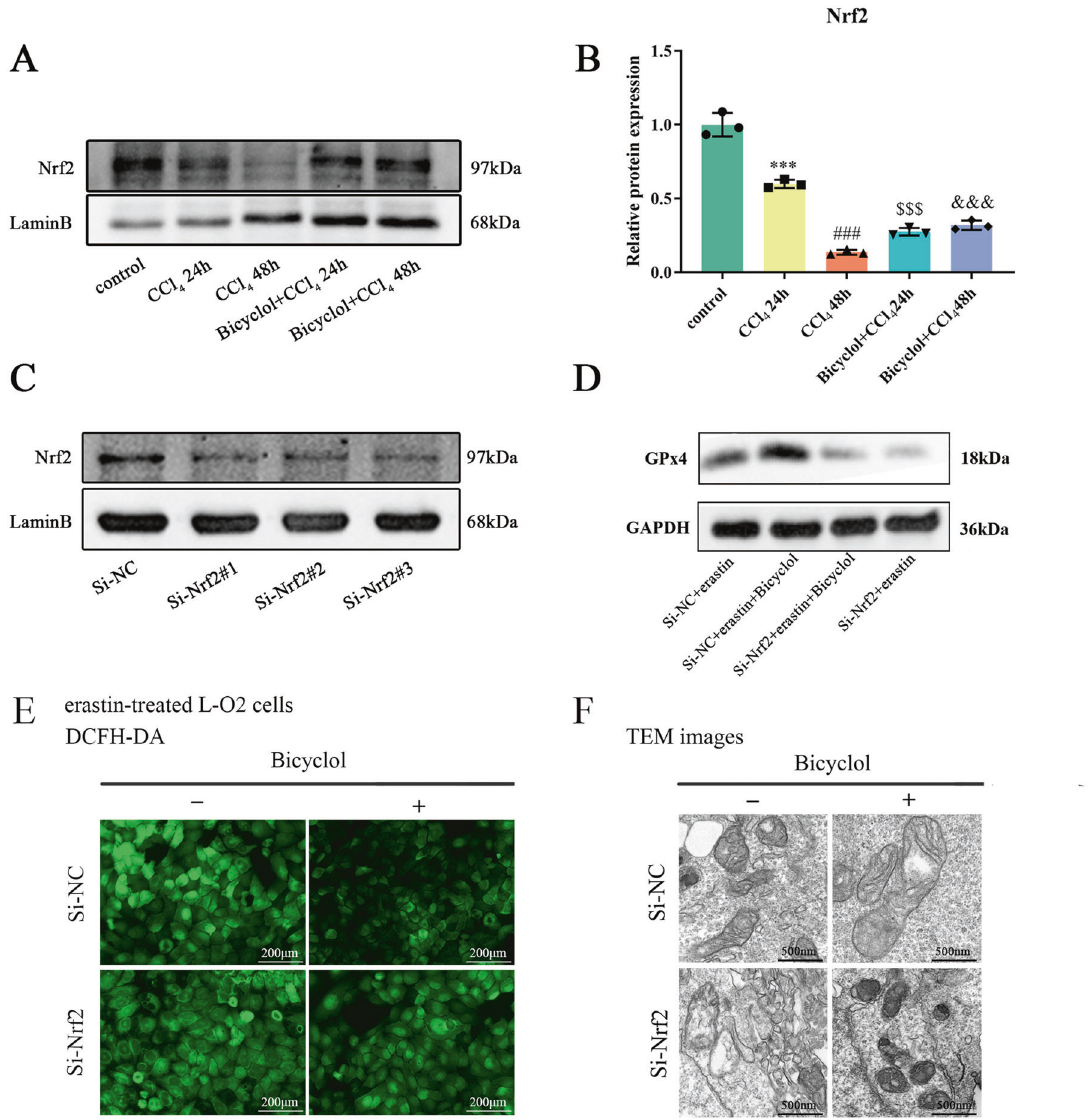
Fig. 8 Bicyclol attenuates hepatocellular ferroptosis by regulating Nrf2-GPx4 axis. A Nuclear protein levels of Nrf2 in liver tissues at 24 and 48 h after CCl 4 exposure. B The band intensities of Nrf2 relative to LaminB were quanti fi ed by image J software. C Protein levels of Nrf2 in L-O2 cells transfected with nontargeting control siRNA or Nrf2 siRNA. D Protein levels of GPx4 in erastin-treated L-O2 cells transfected with nontargeting control siRNA or GPx4 siRNA. E Cellular ROS content in L-O2 cells transfected with nontargeting control siRNA (NC siRNA) or Nrf2 siRNA was assessed by DCFH-DA probe. F TEM was used to detect the mitochondrial morphology of L-O2 cells transfected with NC siRNA or Nrf2 siRNA upon different treatment. Data were expressed as mean ±SD. *** p <0.001 vs control group, ### p <0.001 vs control group, $$$ p <0.001 vs CCl 4 24h group, &&& p <0.001 vs CCl 4 48h